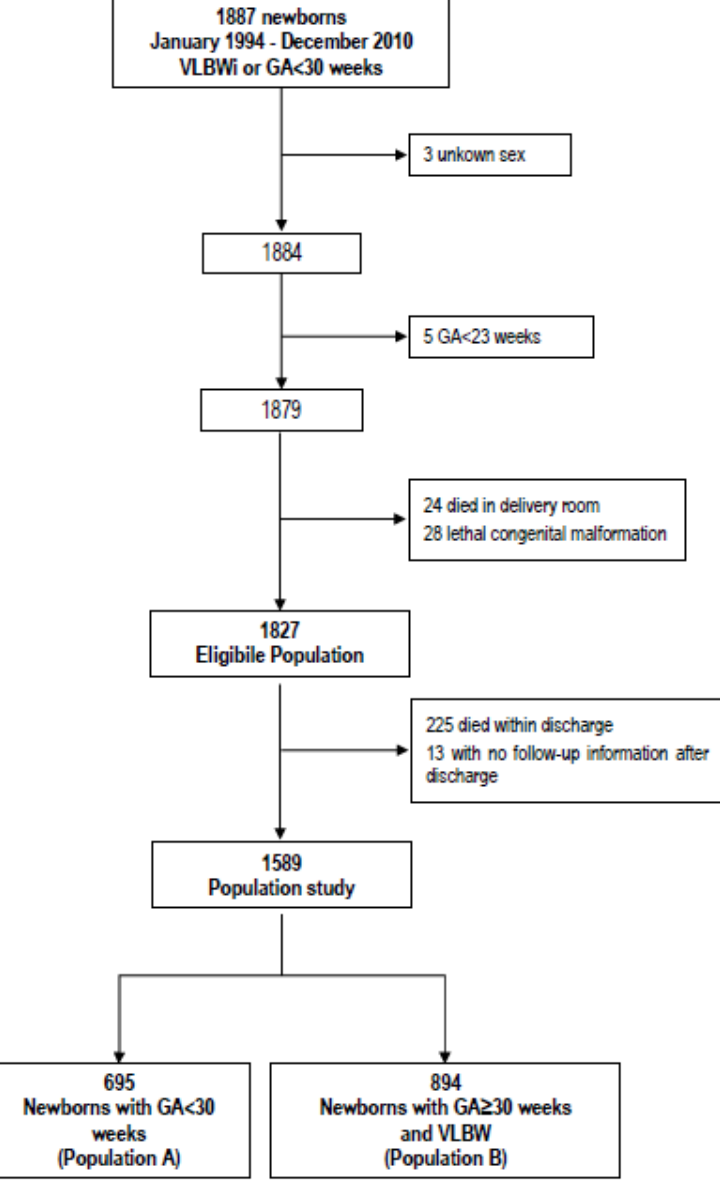
Figure 1. Inclusion criteria and definition of population study. GA: gestational-age; VLBWi: Very Low Birth Weight infants; VLBW: Very Low Birth Weight.